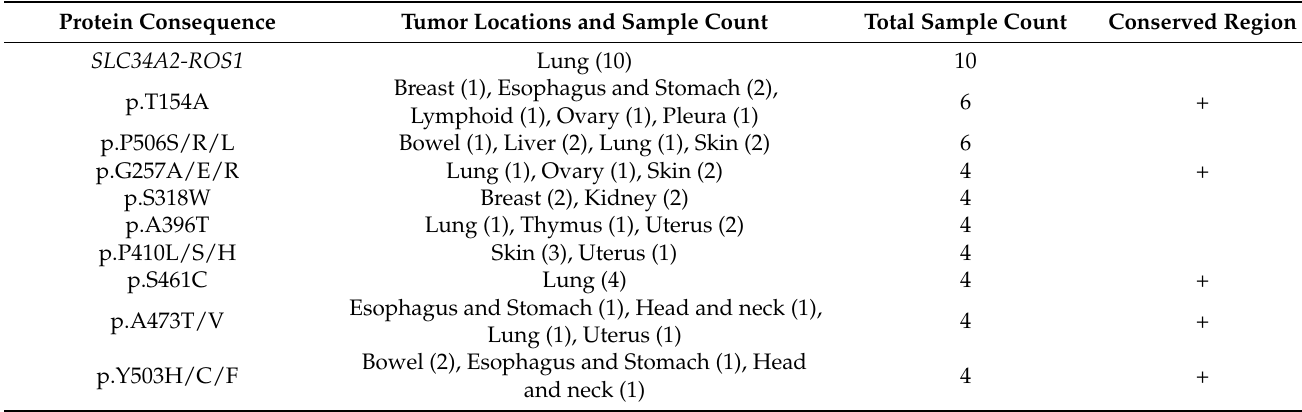
Table 2. The most frequent mutations in SLC34A2 with the sample count according to the tumor location and total sample count, and the indication of highly conserved